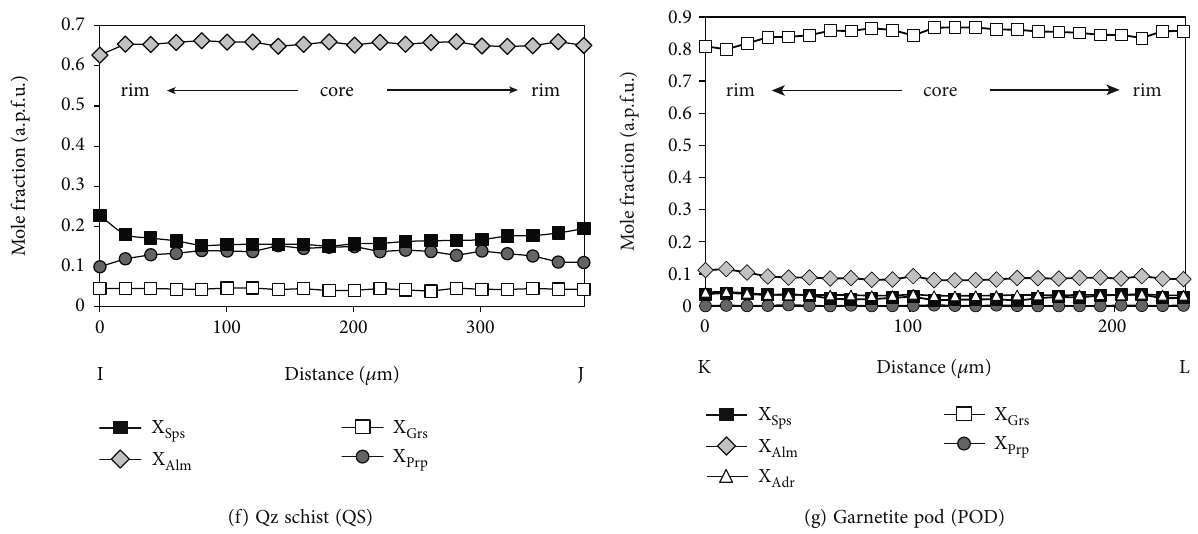
Figure 5: (a) Ternary diagram of garnet compositions in the pegmatites and schists. (b – g) Garnet end-member compositions (atoms per formula unit [apfu]) of the garnet pro fi les shown in Figure 6: (b) A – B in PgD, (c) C – D in PgC, (d) E – F in PgB, (e) G – H in BSa, (f) I – J in QS, and (g) K – L in POD. Note that the x -axis scale varies in each